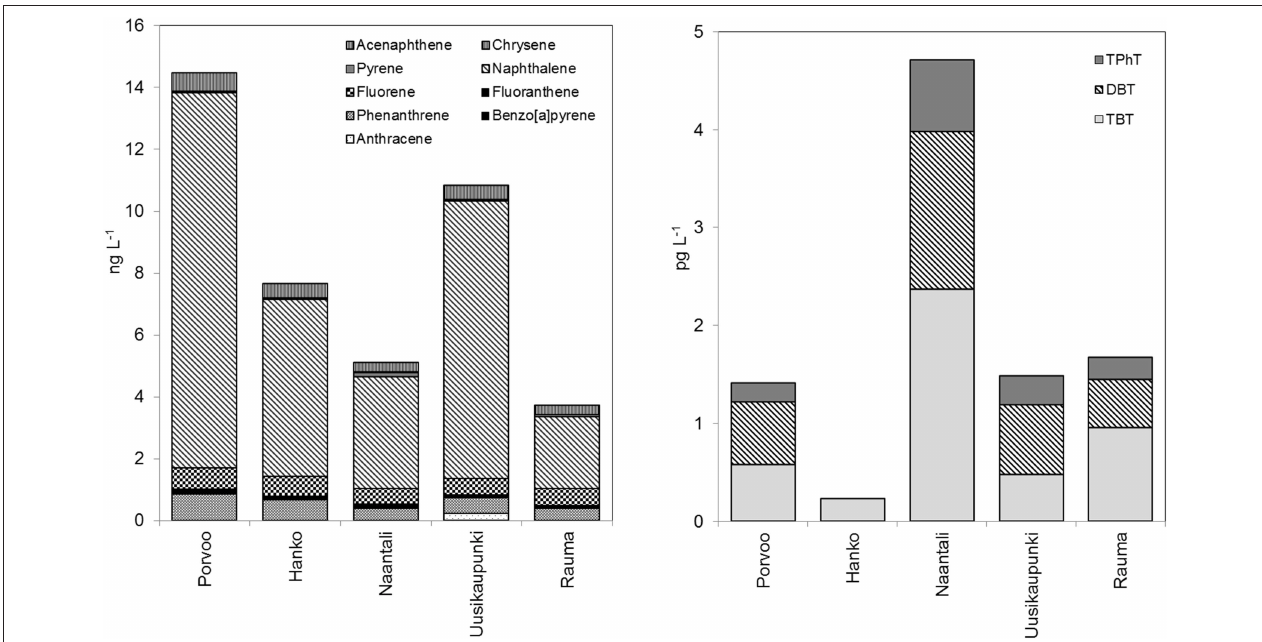
FIGURE 4 | Seawater concentrations of PAHs (ng L − 1 ) and organotins (pg L − 1 ) calculated from accumulated amounts in passive samplers depolyed at five mussel caging sites in 2017.